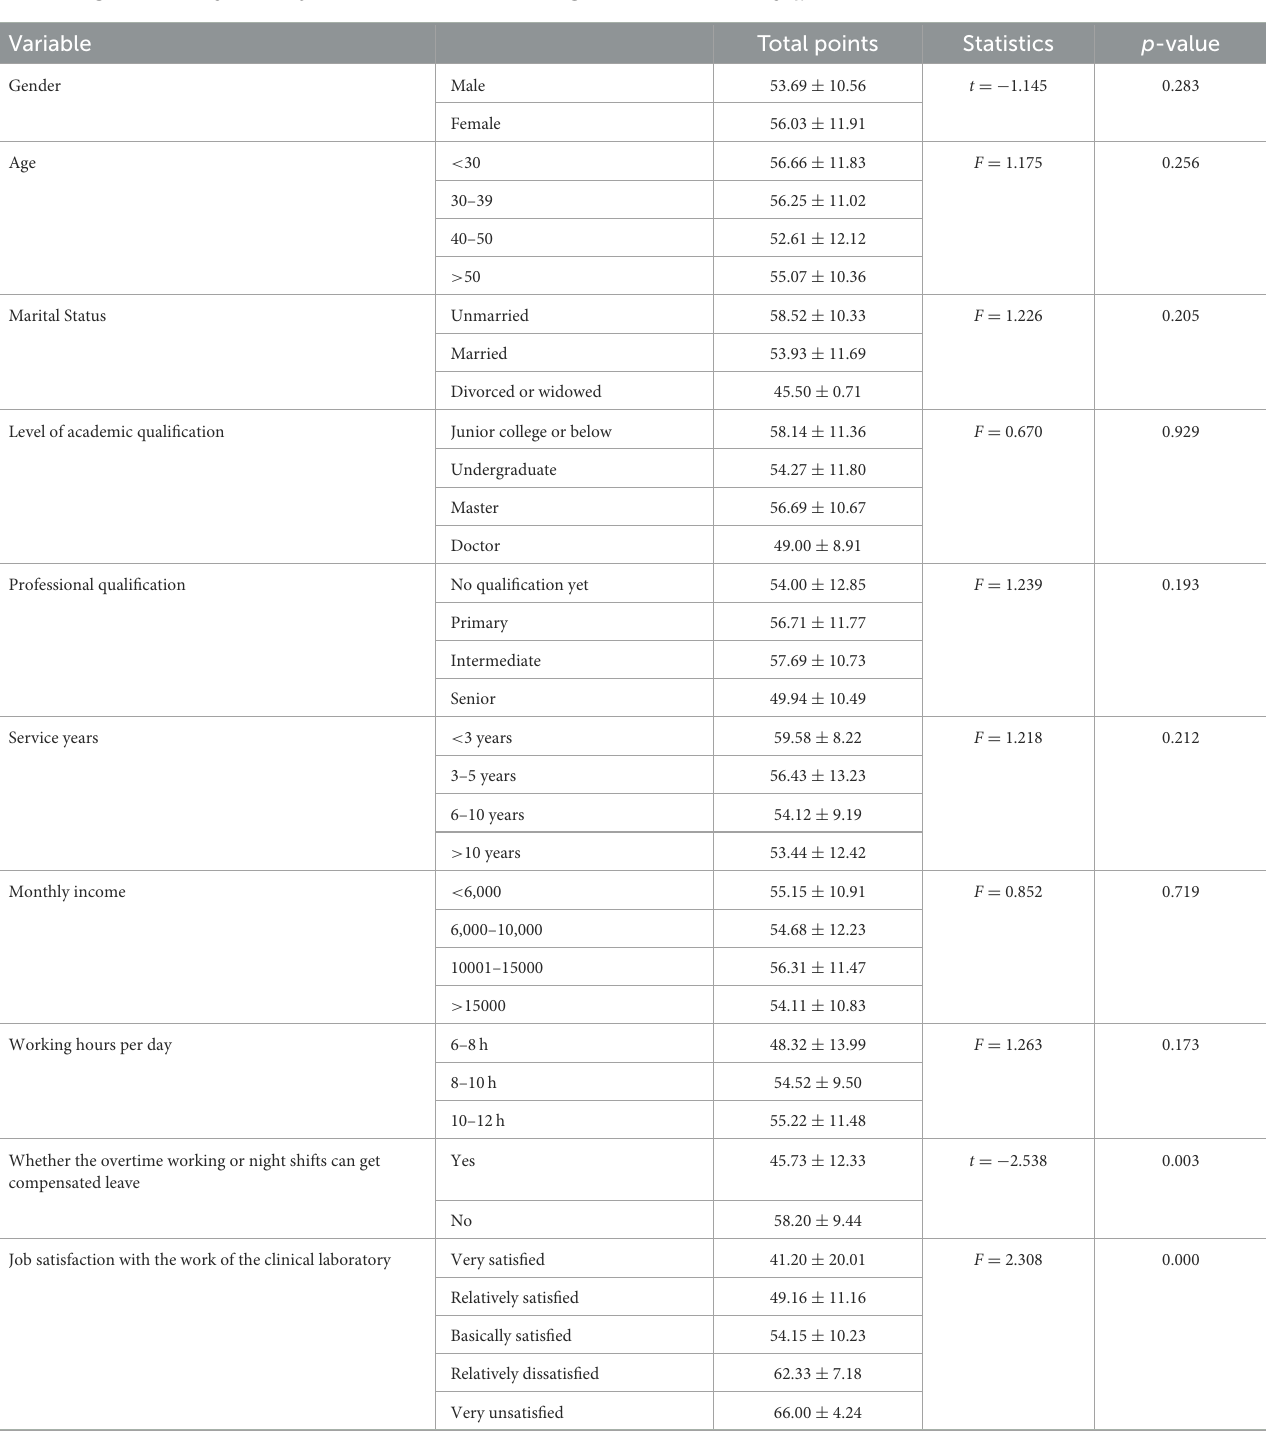
TABLE 3 Single-factor analysis of the job stress of medical staff working in the clinical laboratory ( χ ± s, n = 138).